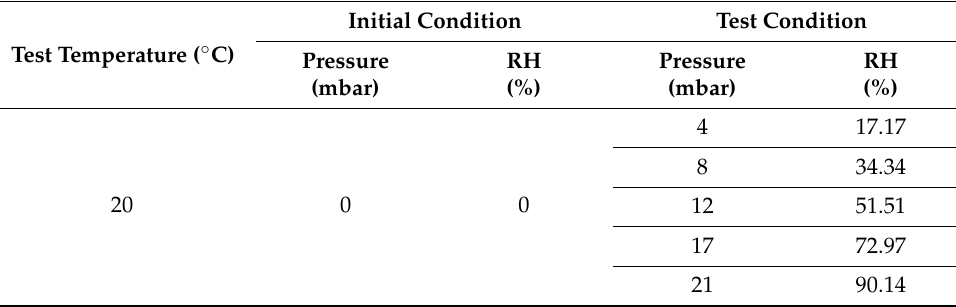
Table 3. Test conditions for the water vapour diffusivities of